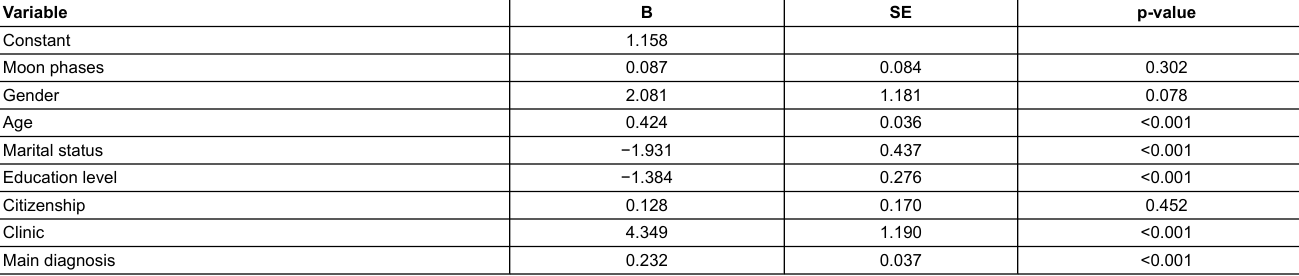
Table 3: Multiple linear regression analysis: adjusted impact of the moon phases at admission on the length of